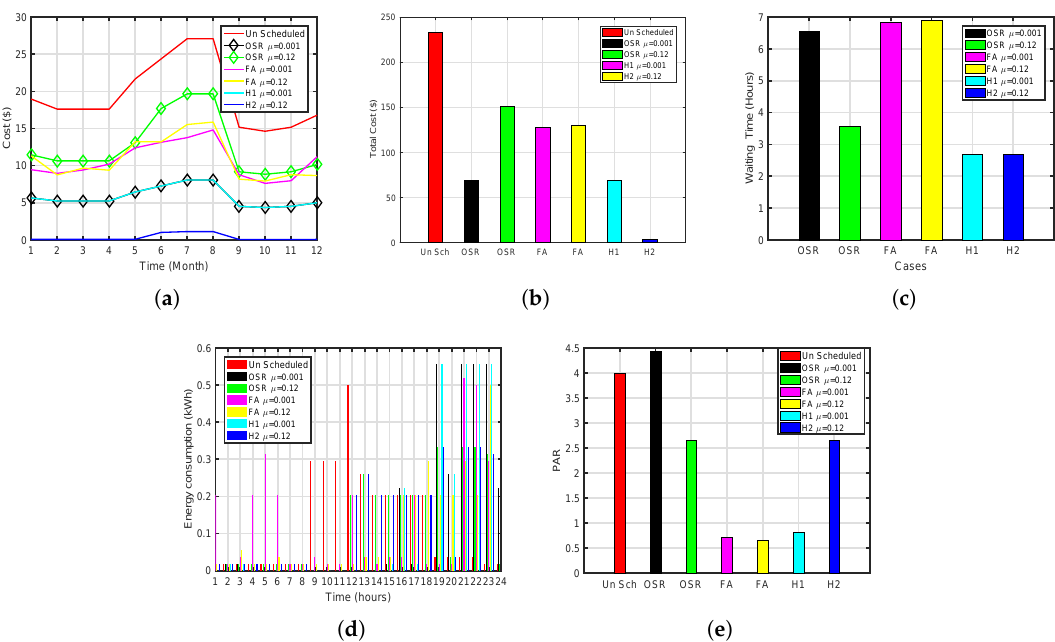
Figure 10. Hybrid Plots for Cloth Dryer (OSR-FA). ( a ) Monthly Cost of Cloth Dryer (OSR-FA), ( b ) Total Cost of Cloth Dryer (OSR-FA), ( c ) Waiting Time of Cloth Dryer (OSR-FA), ( d ) Energy Consumption of Cloth Dryer (OSR-FA), ( e ) PAR of Cloth Dryer (OSR-FA).